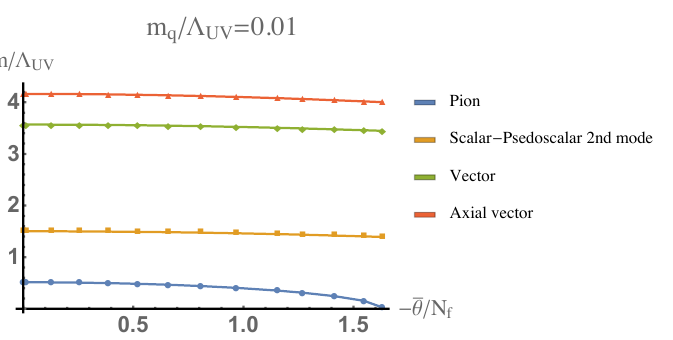
Figure 4. The masses of the lowest (flavor nonsinglet) meson states as a function of ¯ θ at x = 2 / 3 and m q / Λ UV = 0 .